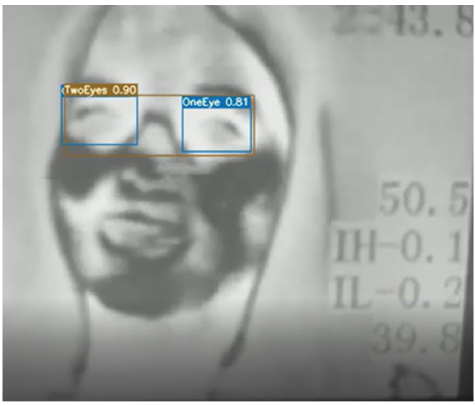
Figure 19. Detection of eyes in video scene by YOLOv7 model with confidence scores.